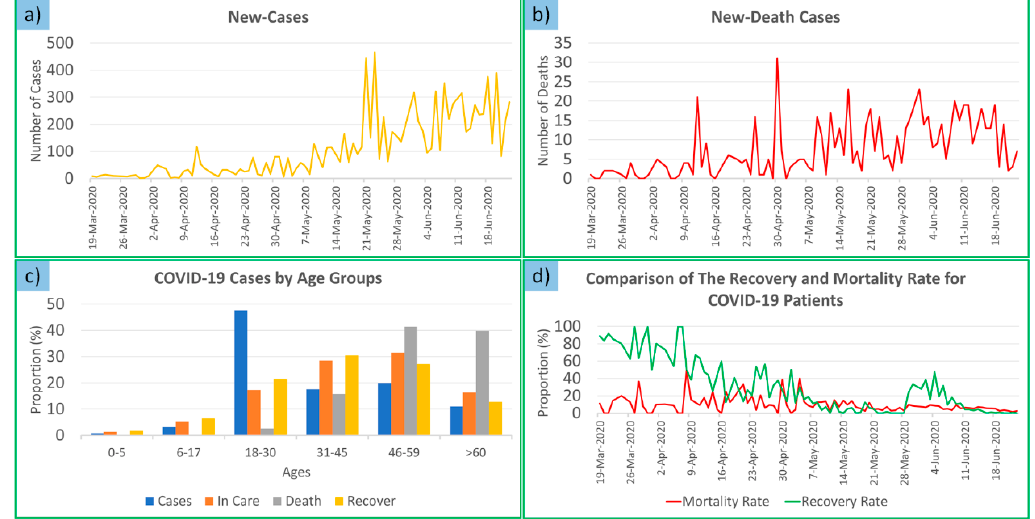
Figure 3. ( a ) The trend of confirmed nonspatial data on cases of COVID-19. ( b ) The trend of confirmed nonspatial data on the death of COVID-19 patients. ( c ) The number of COVID-19 cases based on age group proportion. ( d ) Comparison of the recovery and mortality rate for COVID-19